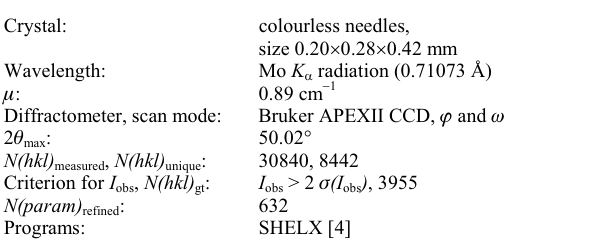
Table 1. Data collection and handling.